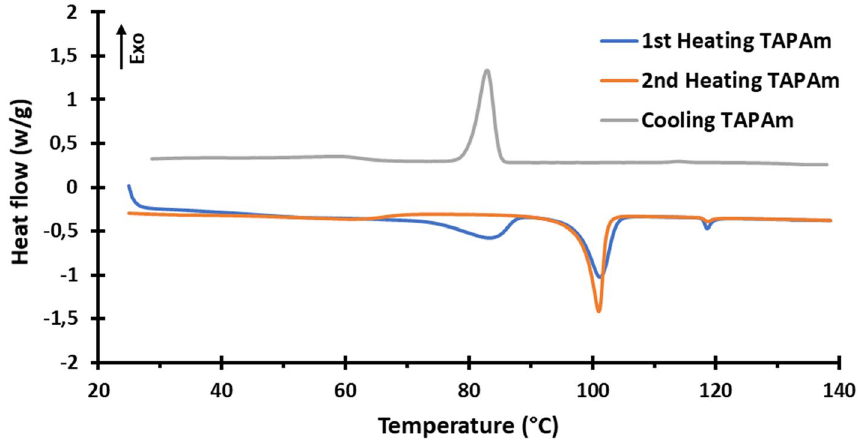
Figure 9. Calorimetric analysis of TAPAm; (blue) first heating, (orange) second heating, and (grey) cooling. Scan rate: 10 °C/min.